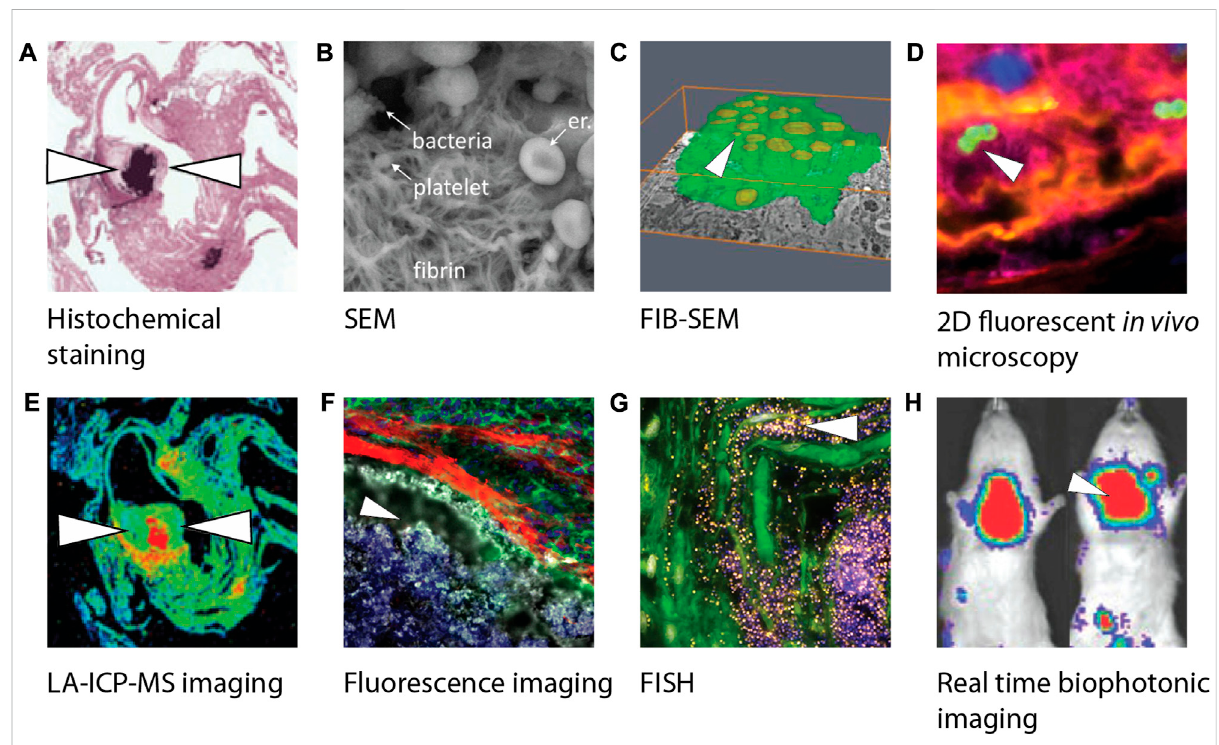
FIGURE 3 Overview of different bio fi lm visualization modalities used in infective endocarditis research. (A) Crystal violet staining visualizing gram-positive bacteria of paraf fi n-embedded female C57BL/6 mice heart tissue slices using light microscopy (Schwarz et al., 2022). (B) SEM image visualizing bacteria including a platelet-containing fi brin network (Hannachi et al., 2020). (C) Three-dimensional reconstruction of phagocytic cells (green) infected by bacteria (yellow) using FIB-SEM (Oberbach et al., 2017). (D) Confocal image of an early infective endocarditis lesions in mice visualizing platelets (pink), fi brin (yellow), endothelium (blue) and S. aureus (green) (Liesenborghs et al., 2019). (E) LA-ICP-MS imaging makes it possible to produce a quantitative distribution map (min to max, blue to red) of elemental distribution (Ca, Mg, Mn, Fe, Cu, or Zn) within female C57BL/6micehearttissueinfectedbybacteria(Schwarzetal.,2022). (F) Visualizationofmyeloidcells ’ (green)inabilitytointeractwithbacteria(white) due to a fi brin barrier (red) in endocarditis in mice (Panizzi et al., 2020). (G) Visualization of S. epidermidis on aortic valve tissue with bacteria after incubation with a FISH probe (yellow) and DAPI (blue) (Lauten et al., 2021). (H) Real time imaging of rats infected by S. aureus using a bioluminescent in vivo imaging system (Xiong et al., 2005) showing high (red) to low (blue) bioluminescent signals. White arrowheads indicate the presence of bacteria. Images were adapted with permission from the original publishers and used as examples. SEM, Scanning electron microcopy; FIB-SEM, Focused ion beam scanning electron microscopy; LA-ICP-MS, Laser ablation induction coupled plasma mass spectrometry; FISH, Fluorescence